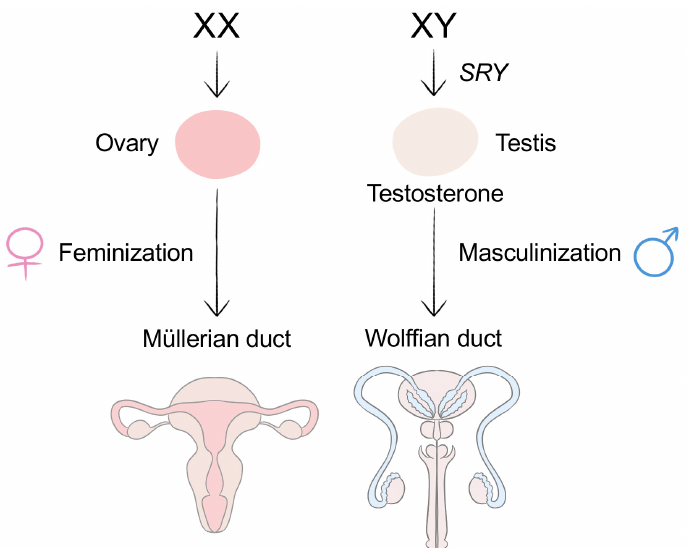
Figure 1. Sexual differentiation of the body. Sex is first determined by the pair of sex chromosomes a zygote contains: XX for females and XY for males. The absence or presence of the SRY gene on the Y chromosome determines whether the sexual differentiation process will be feminization or masculinization. For masculinization, the SRY gene directs the formation of the male-type gonad, testes. For feminization, since there is no Y chromosome and thus no SRY gene to activate the formation of the testis, an ovary is formed. The formed ovary, or the absence of the testis, promotes the Müllerian duct to further develop into female sex organs. For masculinization, the testes produce testosterone, and the development of the Wolffian duct is promoted to form male sex organs.